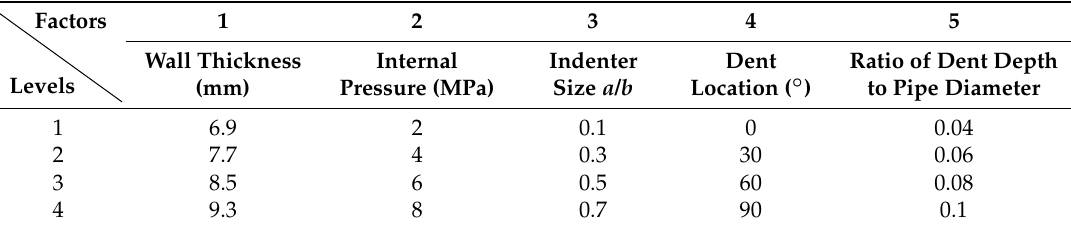
Table 2. Level setting of influencing factors.